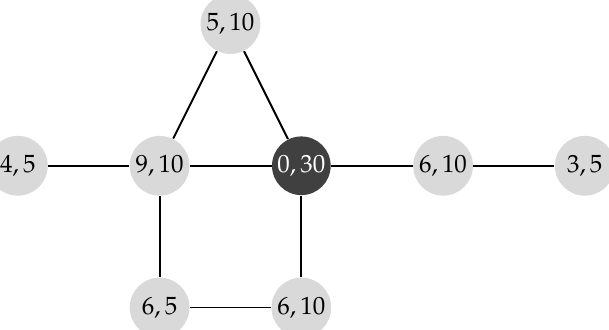
Figure 3. Graph G after performing the main loop of the Algorithm 2 once.